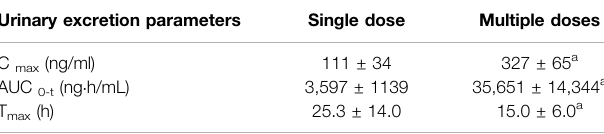
TABLE 2| Urinary excretion parameters oftotalarsenicinhumanurine after single and multiple oral doses of NHJDT (Mean ± SD). Urinary excretion parameters